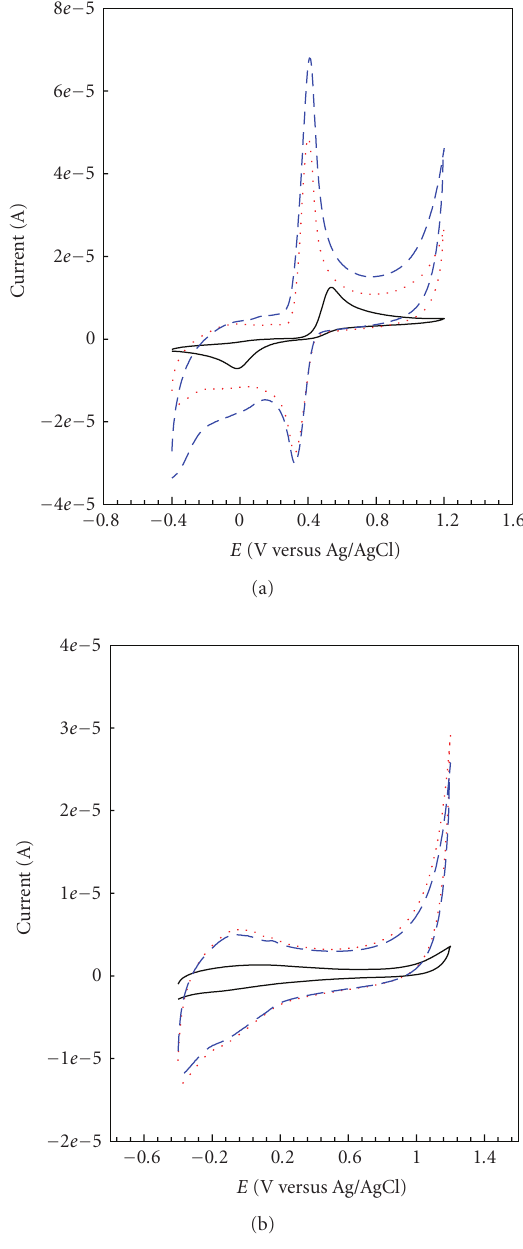
Figure 3: Cyclic voltammograms of various electrodes; bare GCE (—), CNT-GCE ( ··· ), and oppy/MWCNT/GCE (---). (a) 0.1 mM AC and (b) bu ff er solution. Potential sweep rate was 100mVs − 1 and supporting electrolyte was 0.1M phosphate bu ff er solution of pH